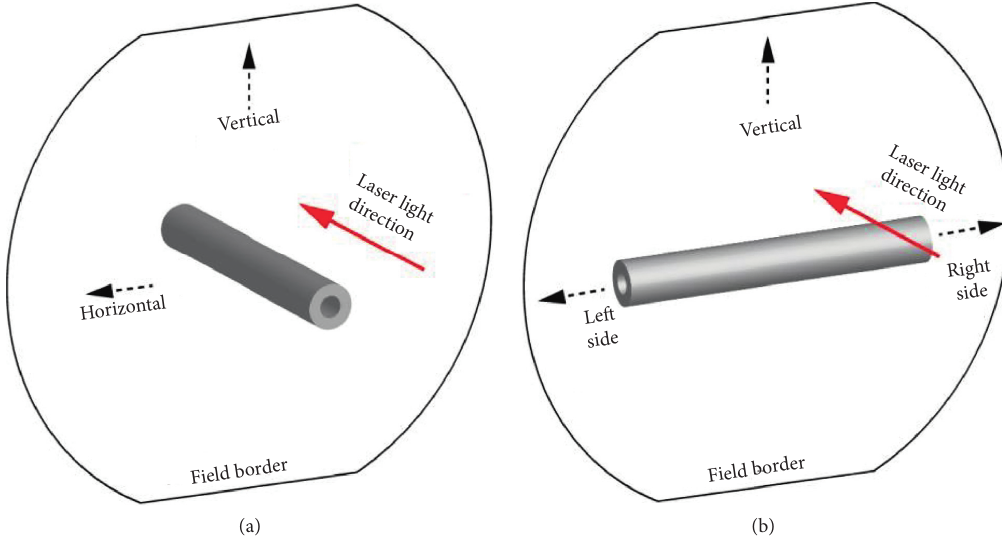
Figure 3: Schematic of the (a) parallel and (b) perpendicular orientations.